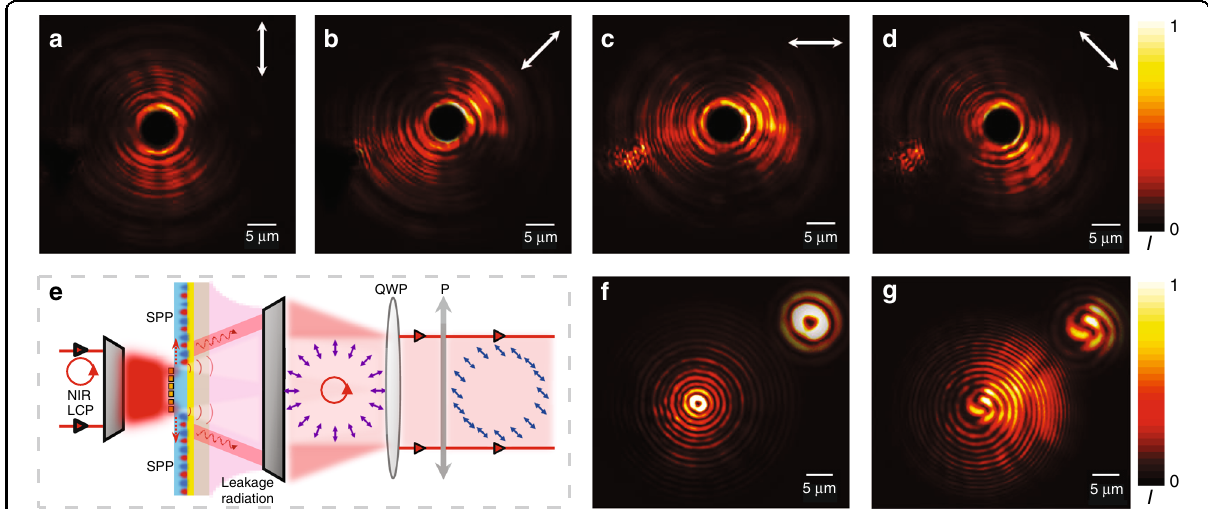
Fig. 8 Characterization of the vectorial and vortex properties of the generated VOF. Optical images recorded by our LRM for the generated VOF after passing through a linear polarizer with a tilt angle of a 0°, b 45°, c 90° and d 135°. e Schematic of the setup for the interference experiment. f Optical image recorded by our LRM for the generated VOF after the polarization- fi lter procedure, as schematically shown in e . The donut shape with an intensity zero in the middle is a typical sign of a vortex beam. g Interference pattern between transmitted light and a spherical wave, recorded by our LRM. The insets in f and g depict zoomed-in pictures of the recorded